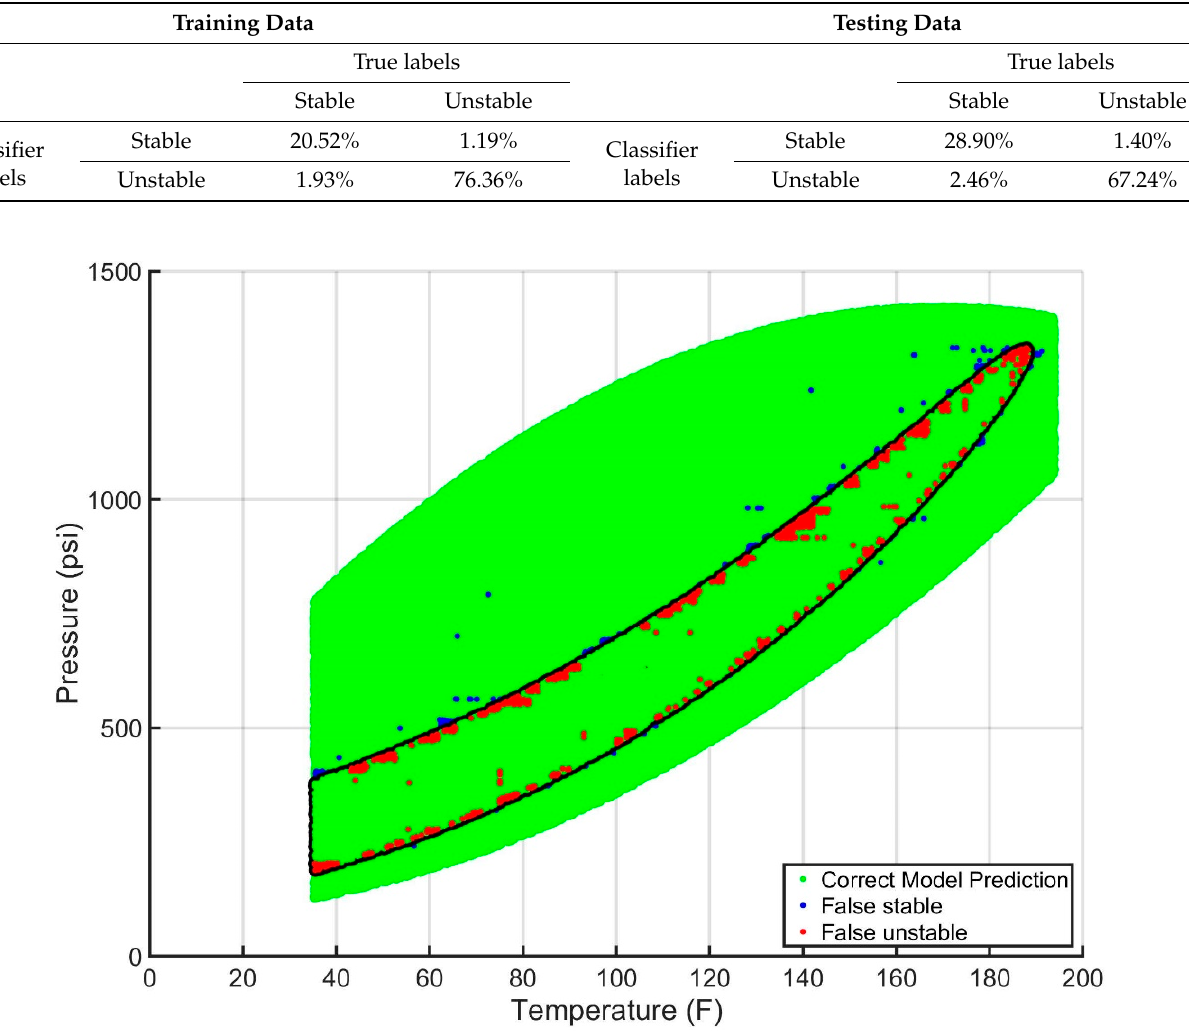
11 Table 2. DT confusion matrices on training and testing data.